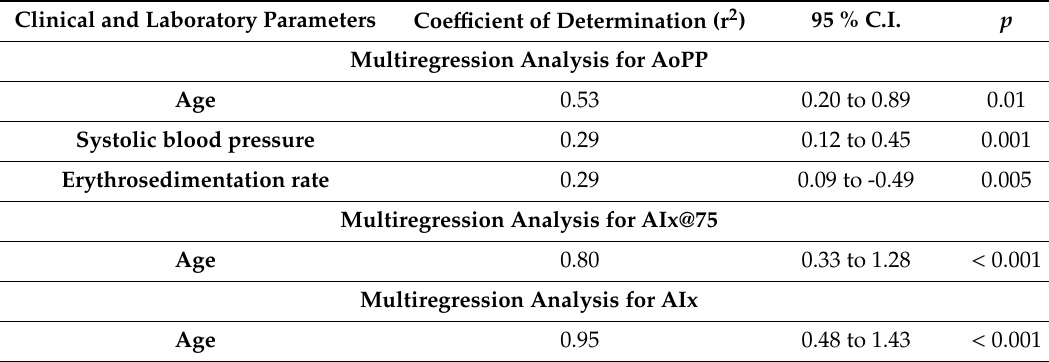
Table 3. Multiregression analysis between markers of arterial stiffness and clinical and laboratory parameters in SLE subjects.